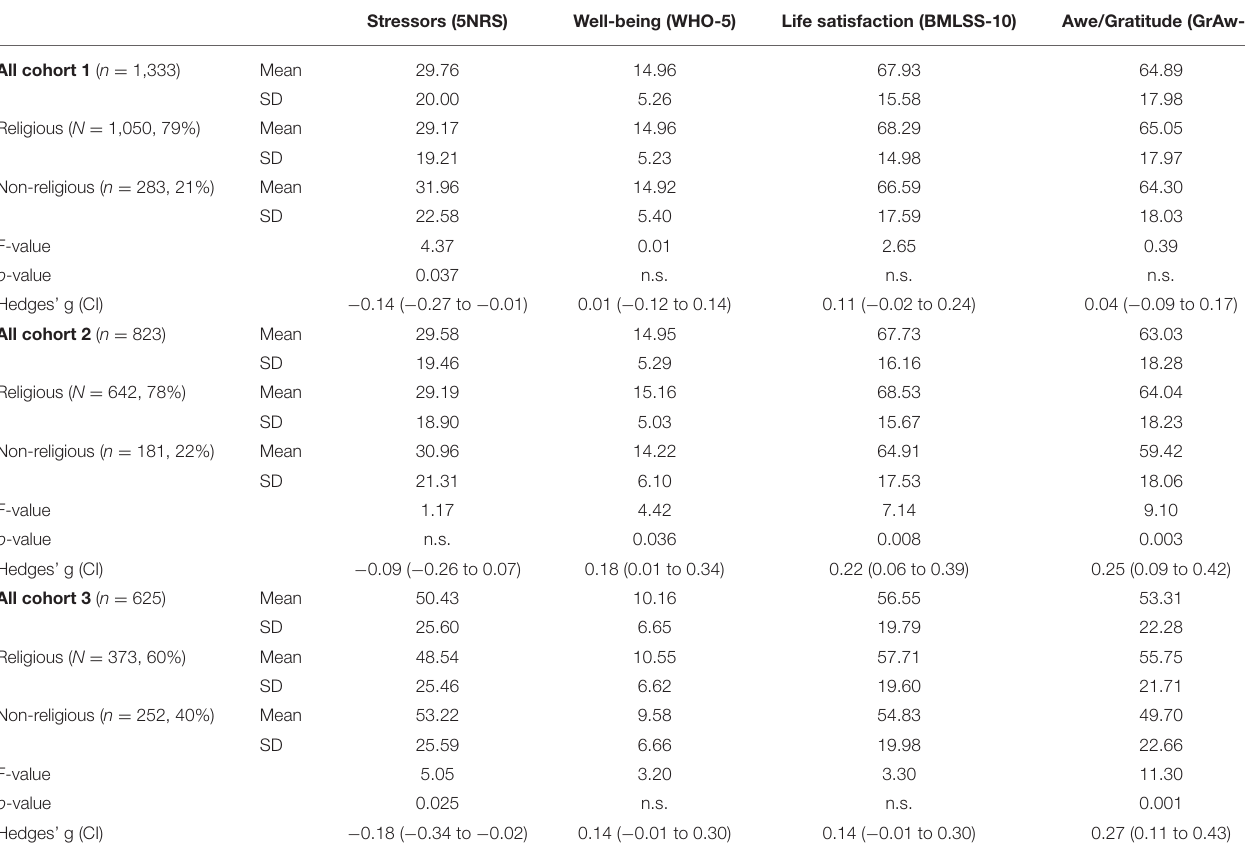
TABLE 5 | Quality-of-life indicators in religious and non-religious persons differentiated within the three cohorts. Stressors (5NRS) Well-being (WHO-5)